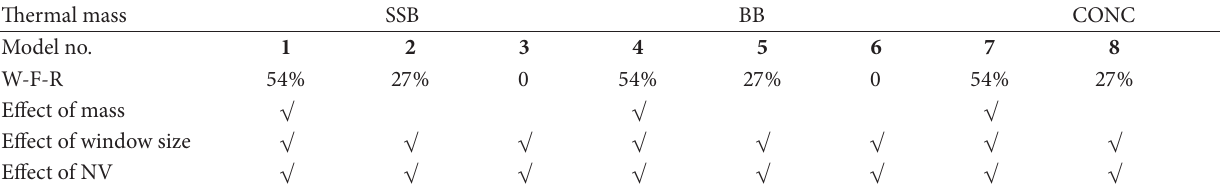
Table 1: Treatments made to the control model.